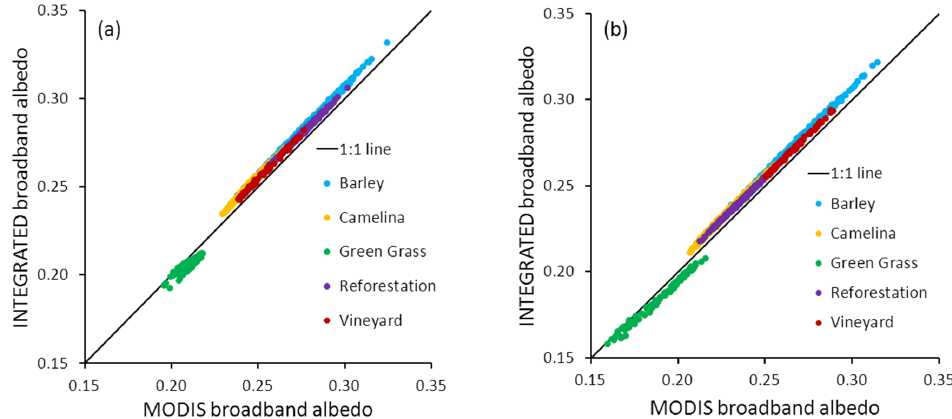
Figure 9. Integrated albedo compared to MODIS albedo for five selected areas. ( a ) Flight at 9:02 UTC on 25 July 2012; ( b ) Flight at 9:46 UTC on 25 July 2012. Each point represents a pixel in the images. The line 1:1 is shown as a guide for the eye.